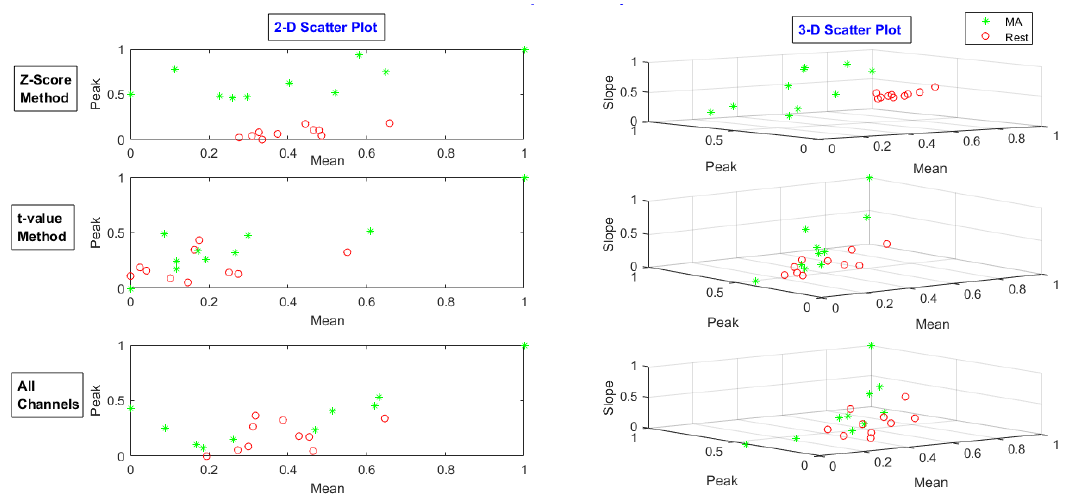
Figure 9. Feature scatter plot of the t -value-method-selected channels’ data, z-score-method-selected channels’ data, and all channels’ data for MA task.